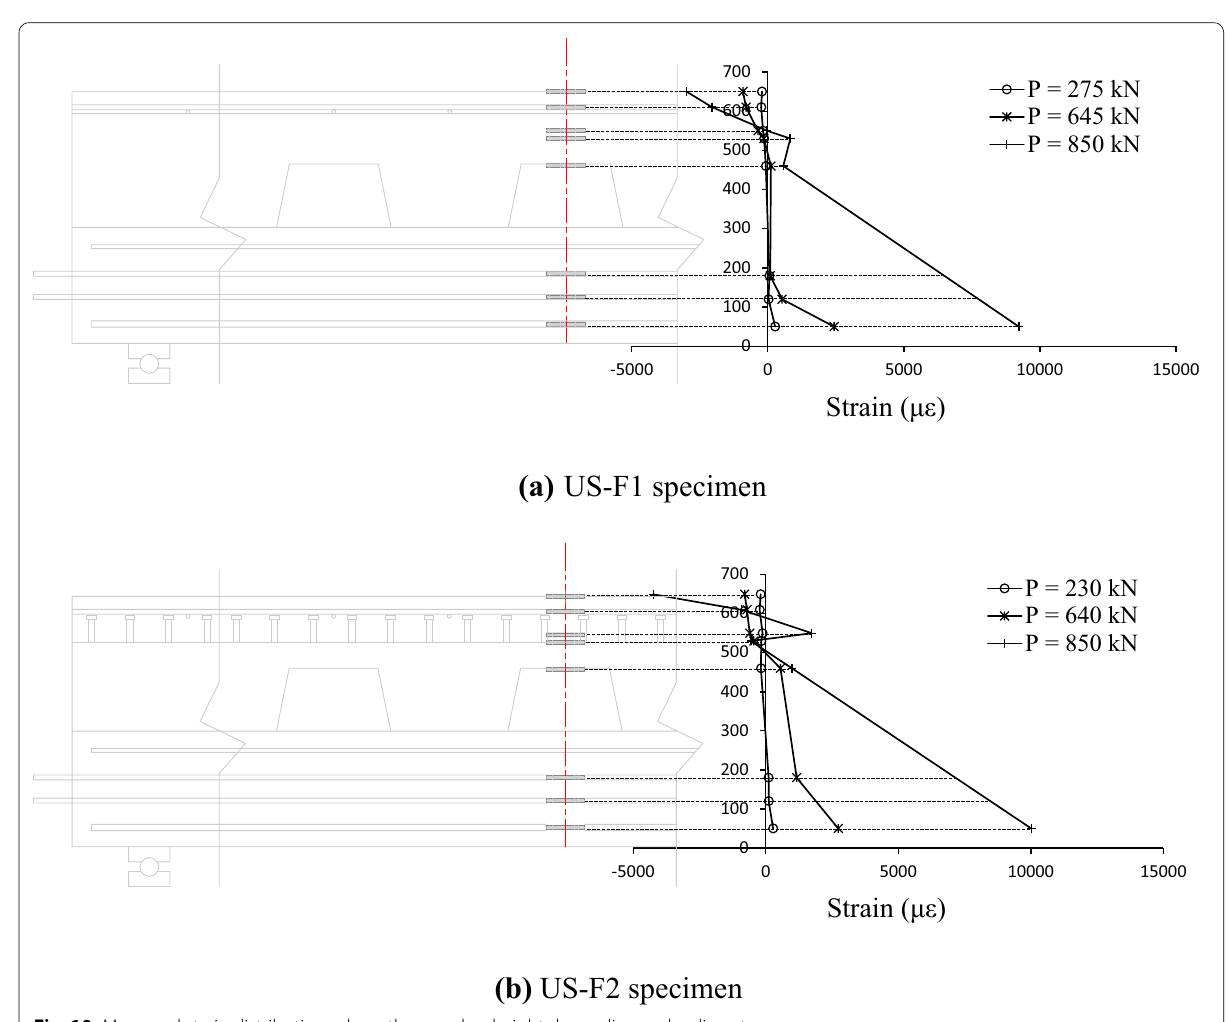
Fig. 10 Measured strain distributions along the member height depending on loading stages.